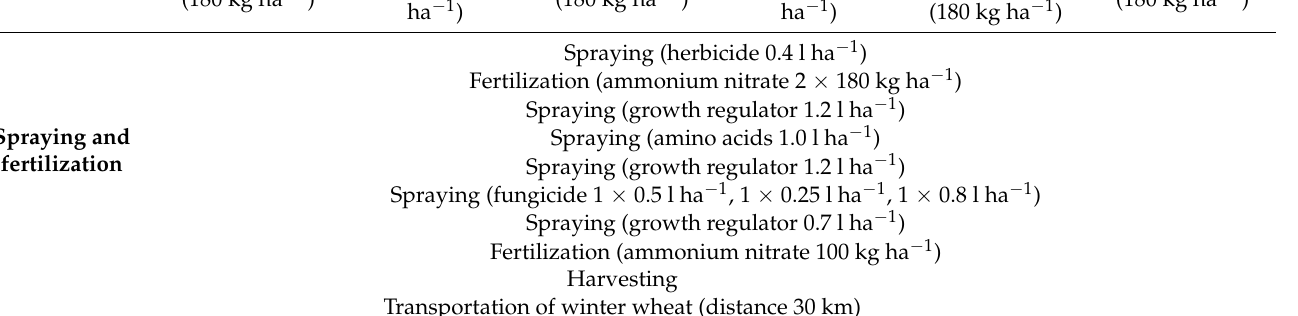
Table 1. Description of winter wheat cultivation technologies using different tillage and sowing methods.